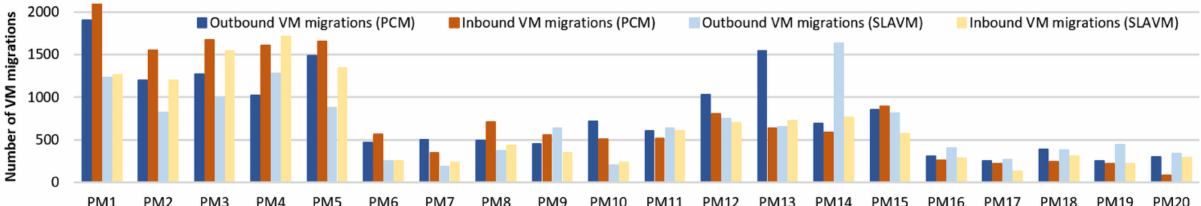
Figure 14. The number of inbound and outbound VM migrations during two simulation runs for both